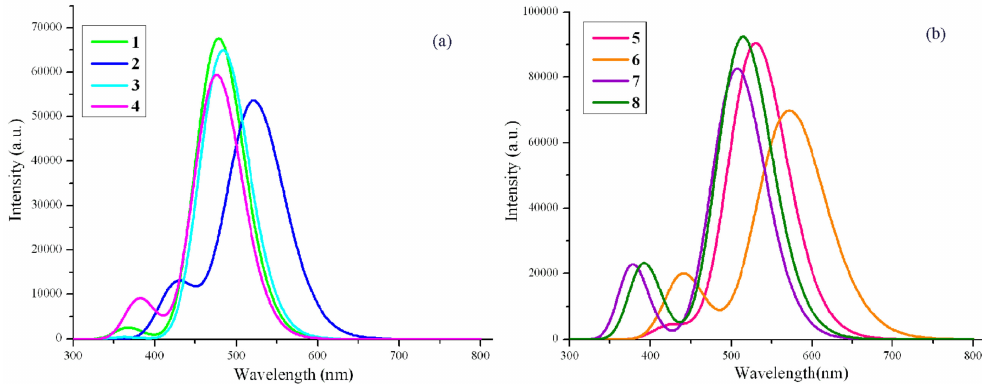
Figure 3. The calculated absorption spectra of the investigated molecules (value of full width at half maximum was 3000 cm − 1 ). ( a ) Molecules 1 – 4 ; ( b ) Molecules 5 – 8